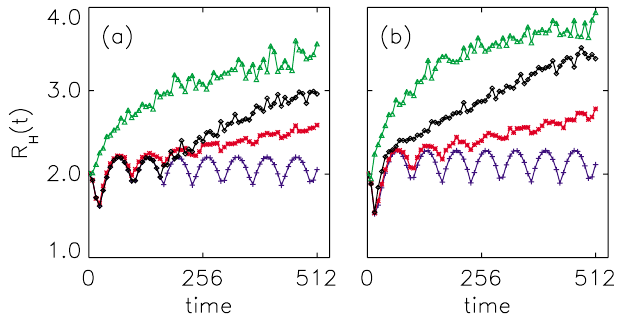
(cid:2) 0 , t (cid:2) 80 , FIG. 2. (Color) Halo amplitude R vs t with (cid:13) H c 2 (cid:2) 0 : 05 , (b) (cid:13) (cid:2) 0 : 1 . The number of test particles is and (a) (cid:13) 1 1 N (cid:2) 10 6 . The four curves correspond to four different noise amplitudes. Blue curve with crosses: hj (cid:22)! ji (cid:2) 0 ; red curve with asterisks: hj (cid:22)! ji (cid:2) 0 : 001 ; black curve with diamonds: hj (cid:22)! ji (cid:2) 0 : 01 ; green curve with triangles: hj (cid:22)! ji (cid:2) 0 : 1 .